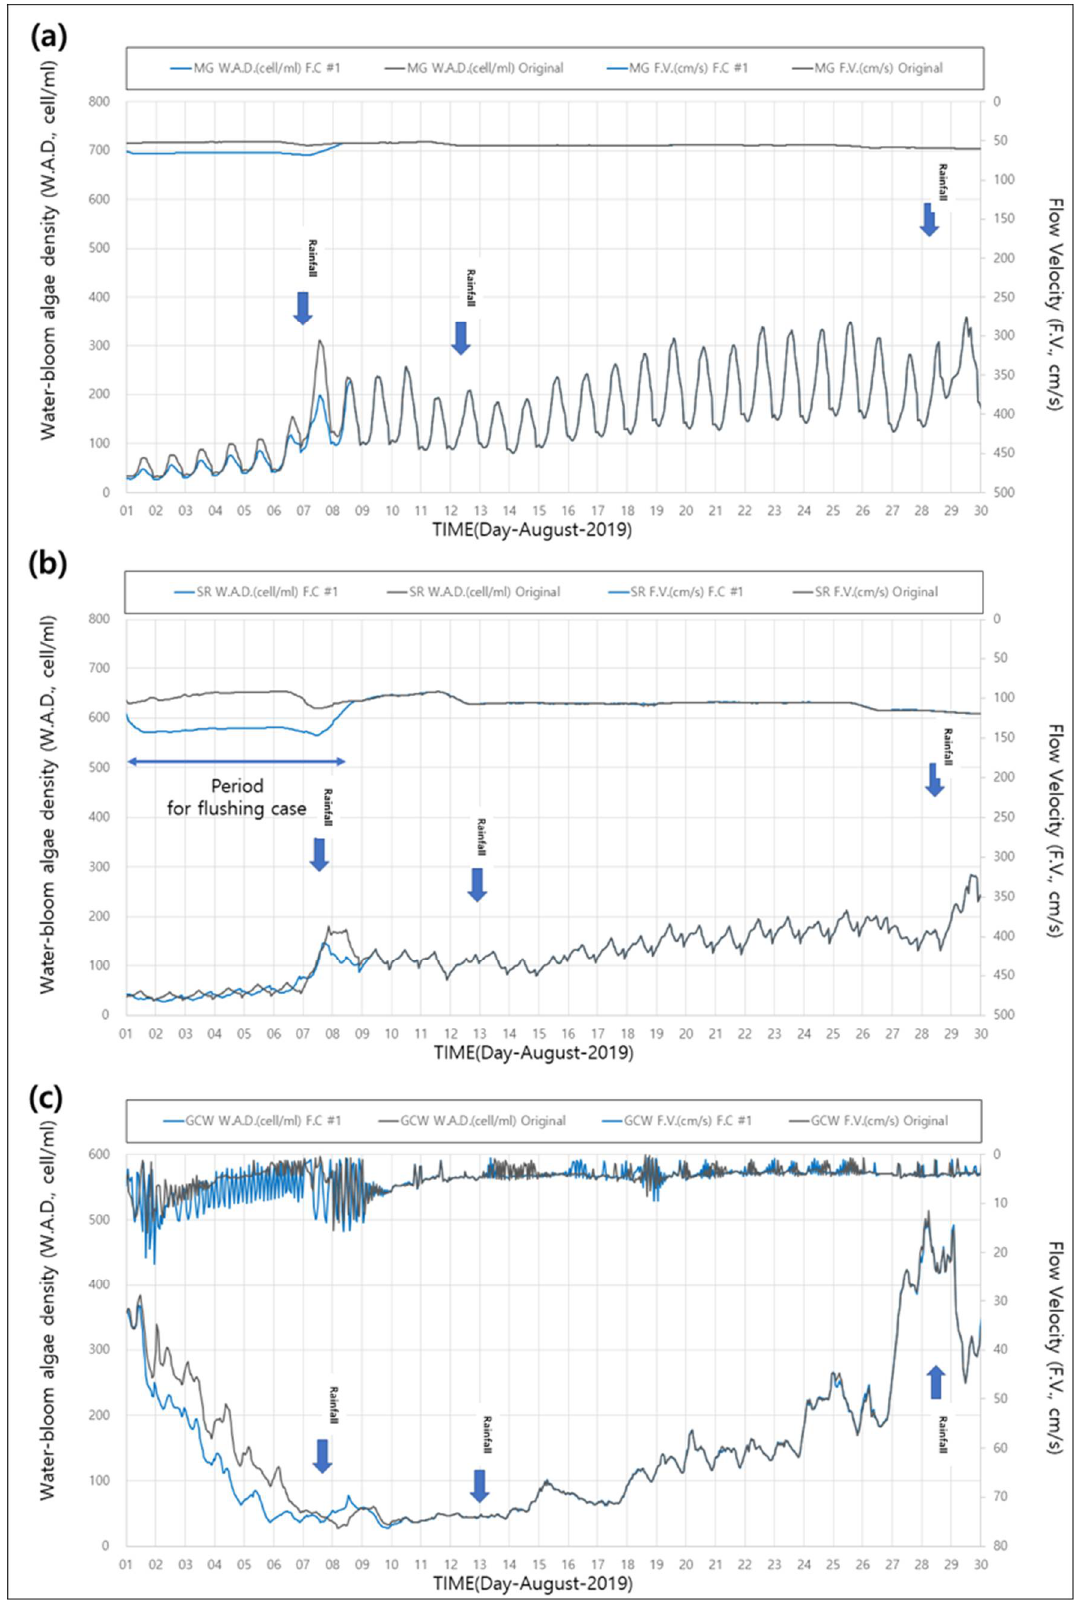
Figure 7. Simulation results of flushing flow with EFDC-NIER model: ( a ) Mokgye, ( b ) Seom river junction, ( c ) Gangcheon Weir.